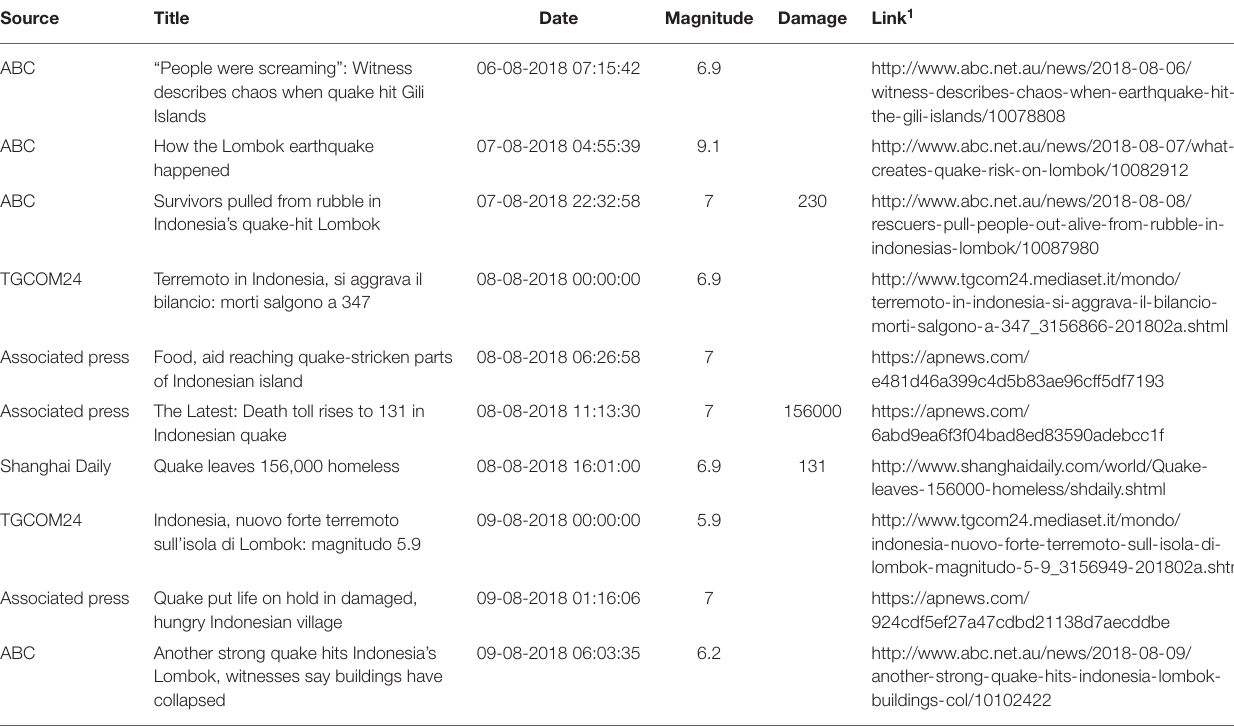
TABLE 2 | Example of news reports when Indonesia was frequently experiencing